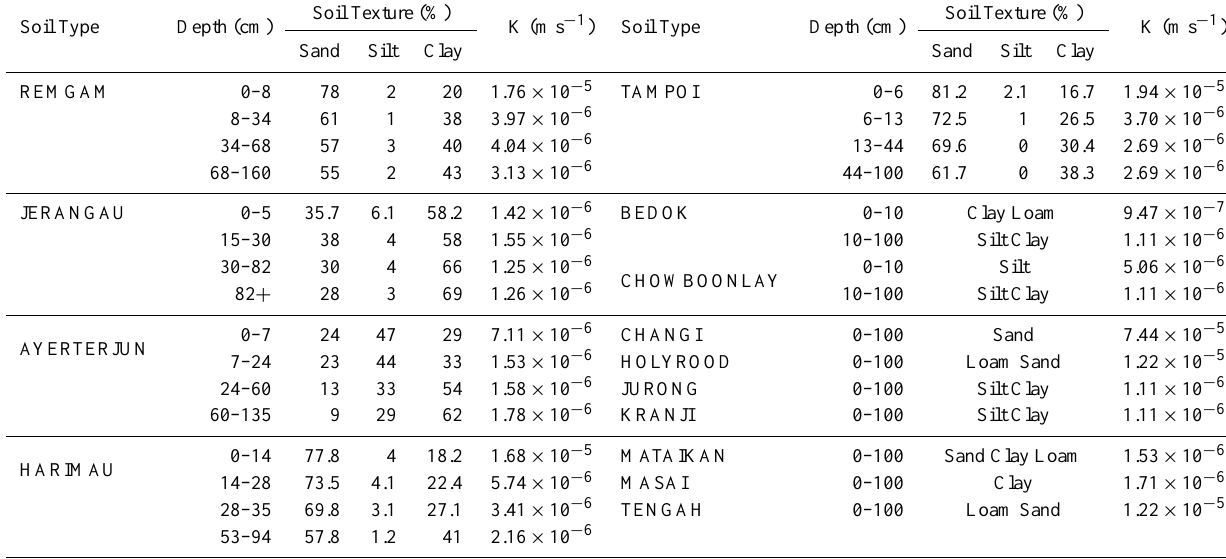
Table 2. Soil texture and